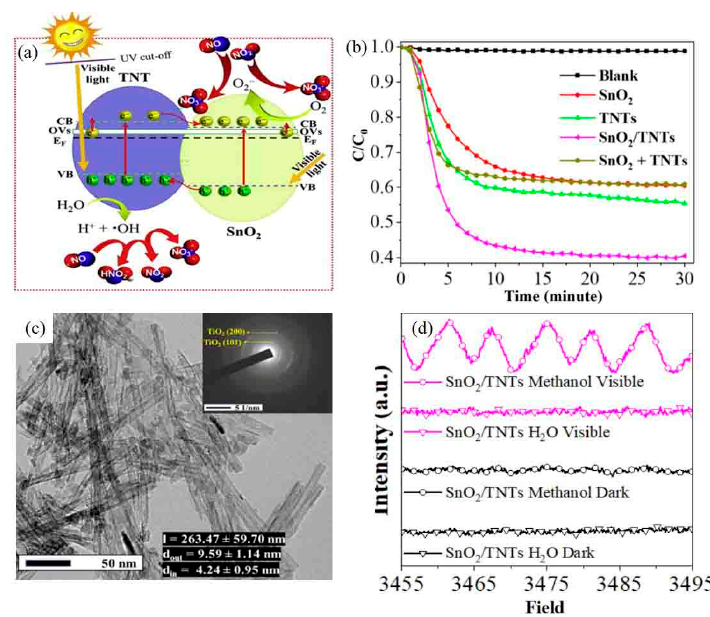
Figure 6. ( a ) Reaction mechanism of visible light removal of NO x by SnO 2 /TiO 2 nanotube heterojunction, ( b ) removal efficiency of NO x under different conditions, ( c ) transmission electron microscopy of SnO 2 / TiO 2 nanomaterials, and ( d ) detection process of free radicals under different conditions [115]. Reproduced from Ref. [115], Copyright 2019, Elsevier.